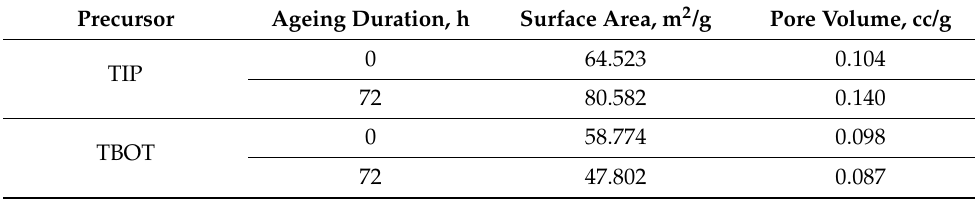
Table 3. Morphological parameters of calcinated aerogels vs. precursor nature and aging duration.